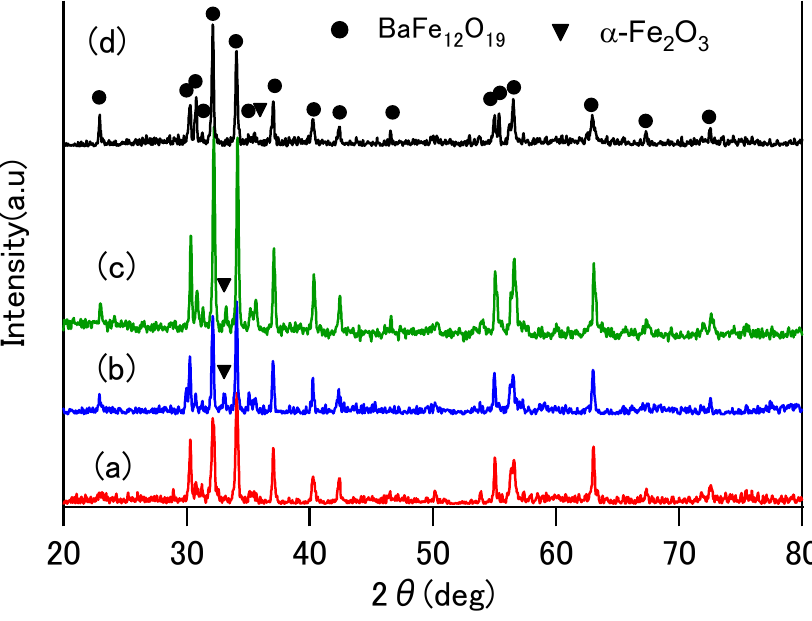
Figure 1. powder XRD patterns of the specimens sintered at: (a) 800 °C, (b) 1000 °C, (c) 1200 °C and (d) 1400 °C for 8 h.